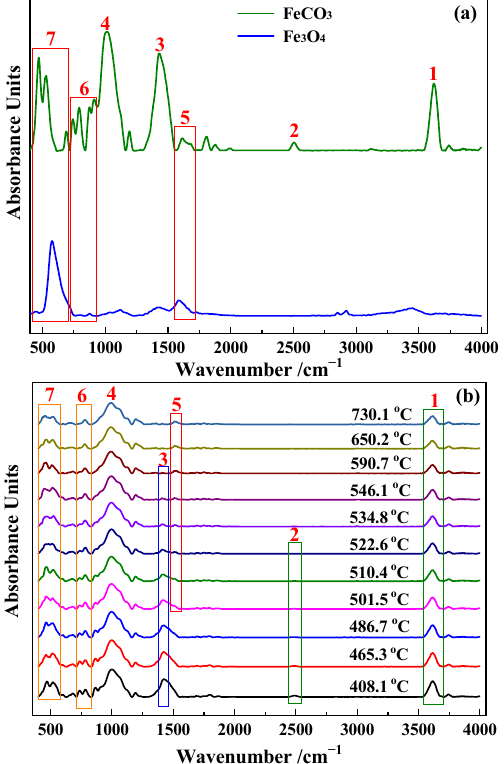
Figure 7. Two-dimensional IR of ( a ) magnetite–siderite and ( b ) roasted ore. The IR absorption spectrum of siderite is very complex, as shown in Figure 7a. Ac- cording to the literature [27], in IR spectra, carbonates typically give rise to signals in the 1600–1300 cm − 1 region, Si–O bond peaks are typically observed in the 1200–1100 cm − 1 re- gion, hydroxyl group peaks in the 3550–3200 cm − 1 and 1100–1000 cm − 1 regions, carbonate and silicate peaks in the 800–745 cm − 1 region, and iron oxide and silicate peaks are ob- served in the 1700–1500 cm − 1 and 705–400 cm − 1 . From this, it can be determined that peaks 1 and 2 in Figure 7a can be attributed to the IR absorption bands of hydroxyl groups (free water or water of crystallization); peak 3 is the IR absorption band of carbonate groups;